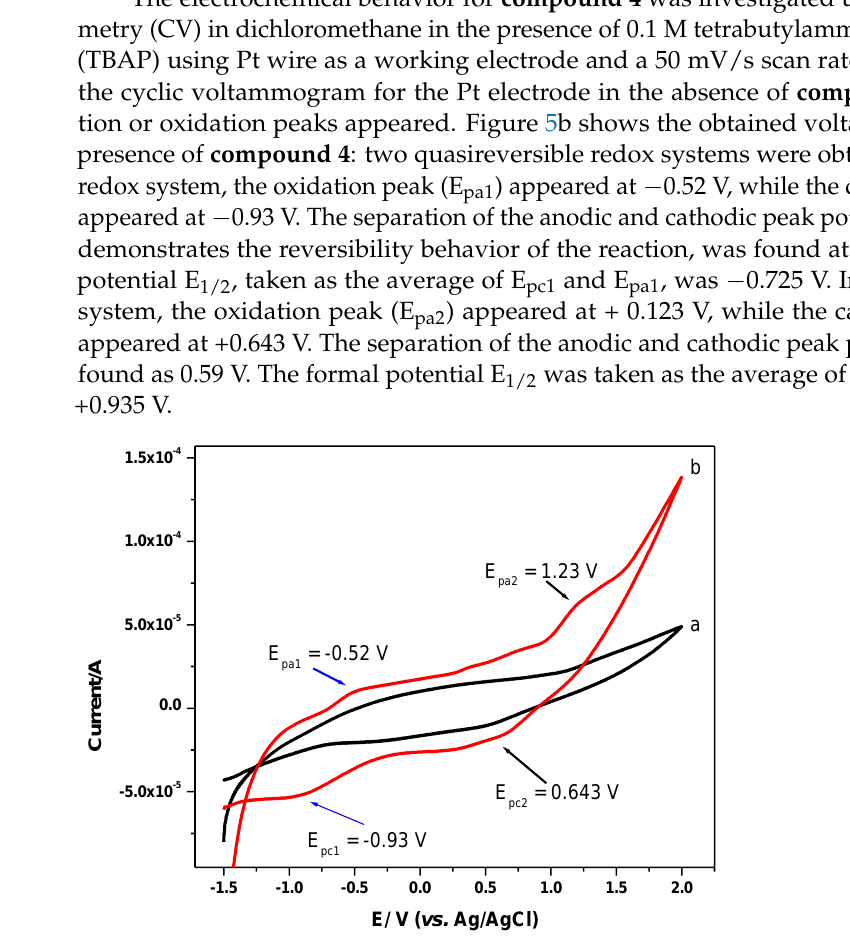
Figure 6. The effect of repetitive cycles on the peak currents of compound 4.